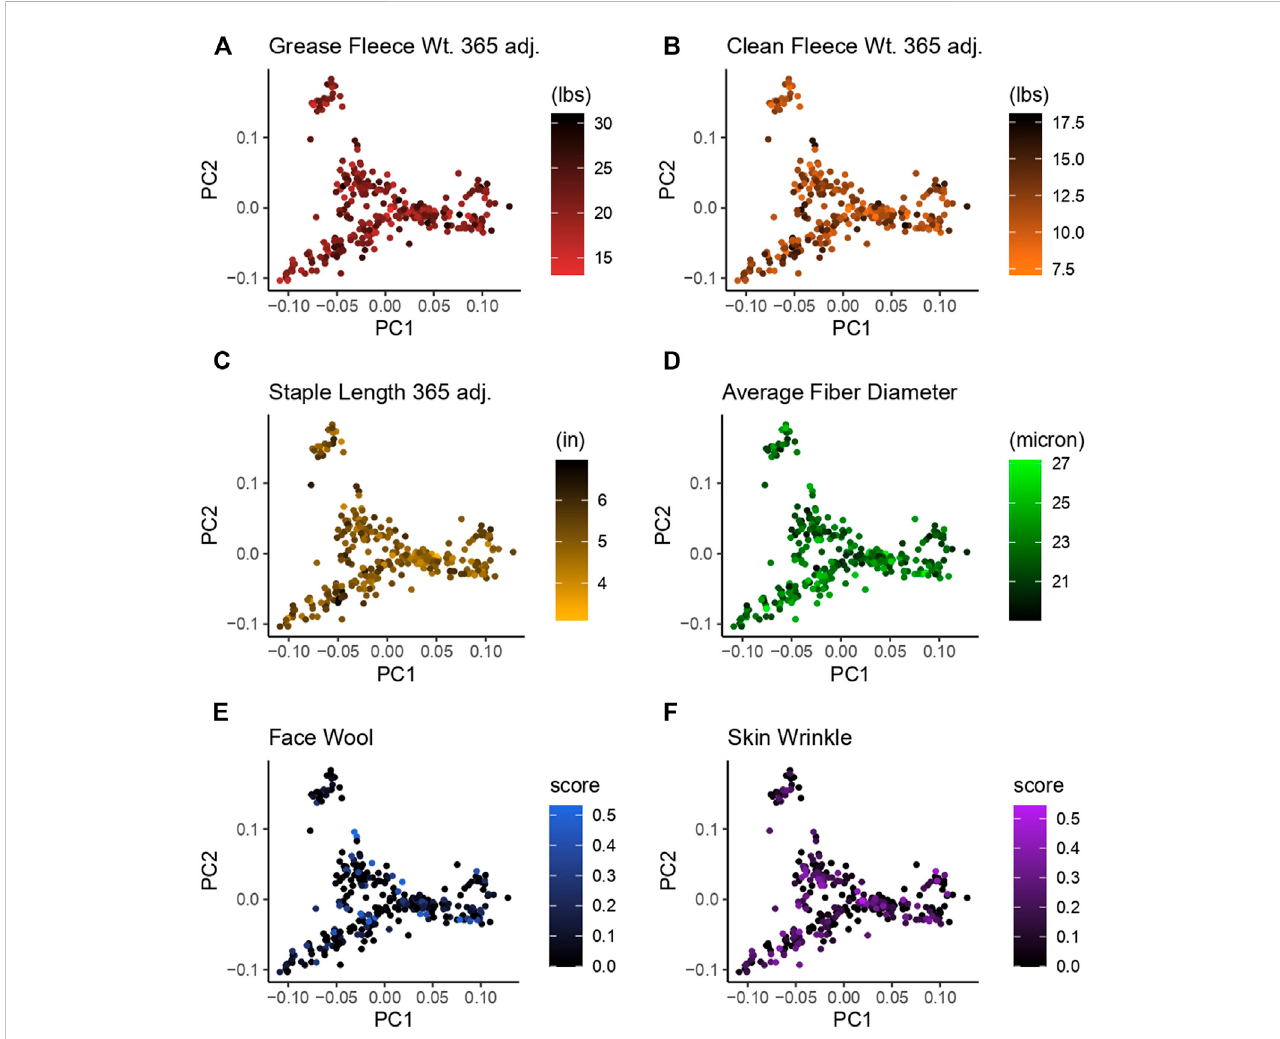
FIGURE 3 Principal component analysis (PCA) for 313 Rambouillet rams. Each panel represents PC1 plotted on the x-axis and PC2 plotted on the y-axis. Rams are color-coded based on their position within the trait distribution, with the most desirable end of the distribution represented by black. Each panel is color- coded low to high: (A) grease fl eece wt. 365 adj., red to black; (B) clean fl eece wt. 365 adj., orange to black; (C) staple length 365 adj., yellow to black; (D) average fi ber diameter, black to green; (E) face wool score, black to blue, (F) skin wrinkle score, black purple. Face wool and skin wrinkle are colored based on log10 transformed